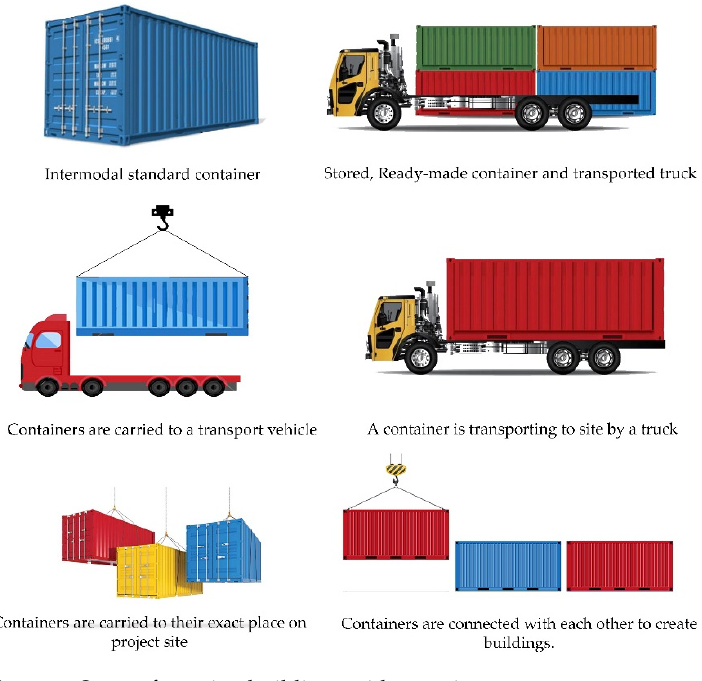
Figure 1. Steps of creating buildings with containers.